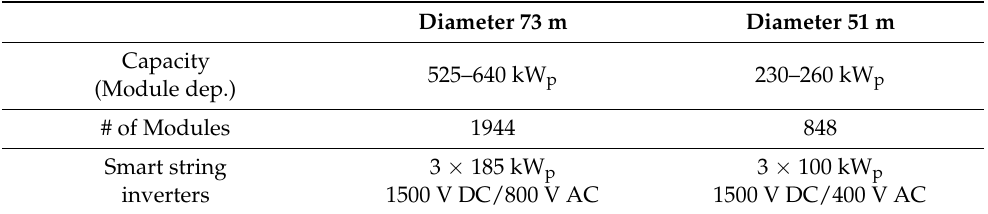
Table 1. The main parameters of the floating thin-film photovoltaic